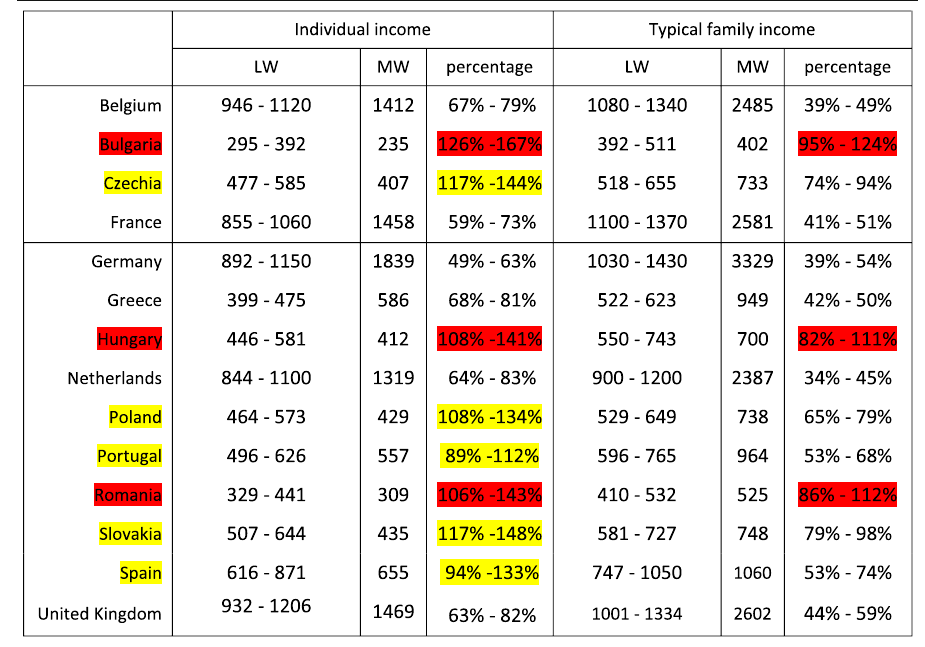
Yellow colour marks countries, for which individual minimum wage is potentially lower than the minimum wage. Red colour denotes those countries, in which even pooled MWs in a family are potentially lower than LW. Source: own calculation based on WI from December 2016. Q1 2017 Eurostat data used for MWs LW living wage (given as an interval), MW minimum wage, Percentage LW as a percentage of